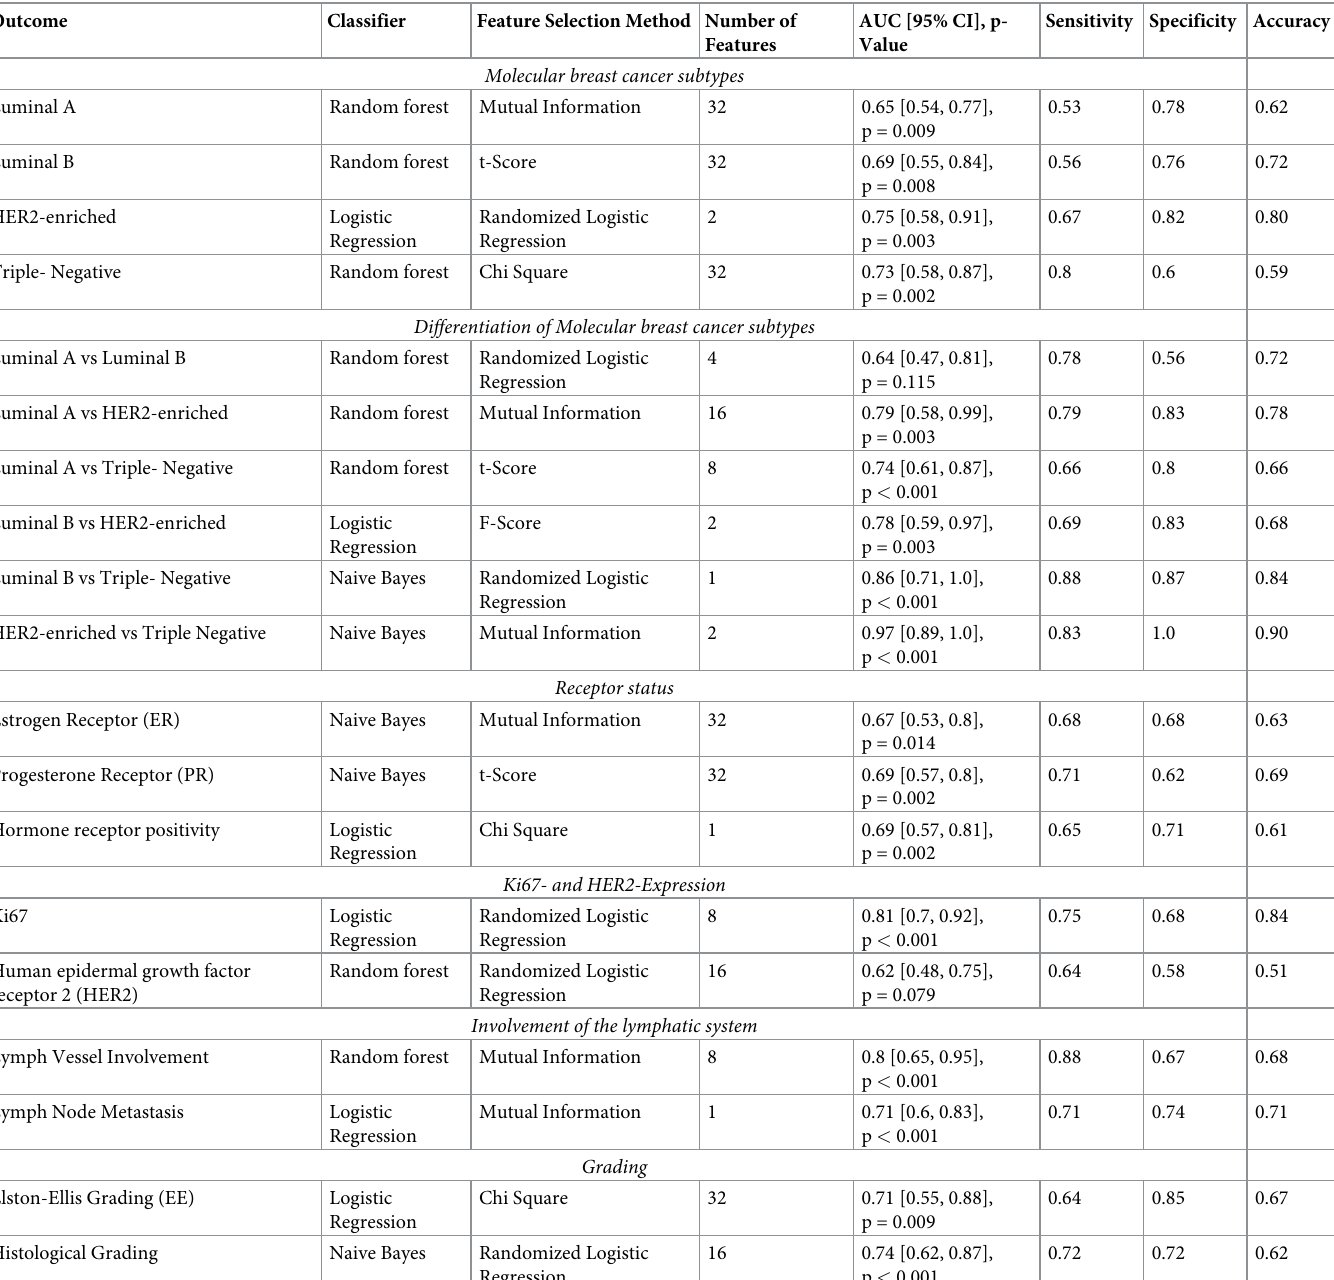
Table 2. Detailed results of the classification accuracies. Results for all classifiers. P-Values were computed using a DeLong test to compare ROC